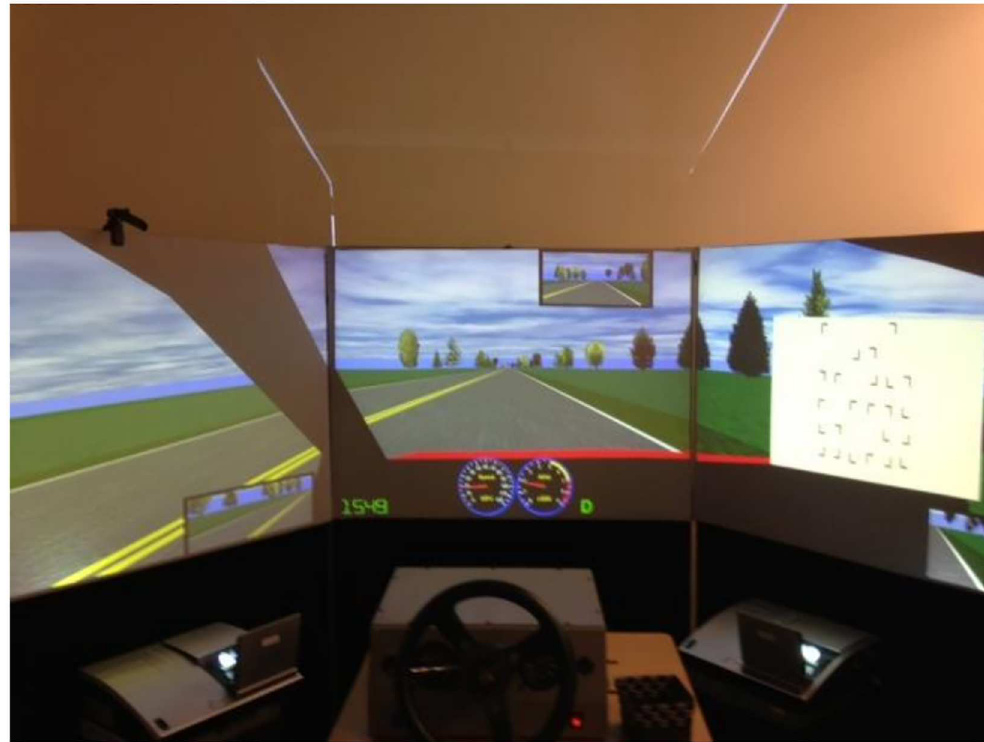
Fig 2. A sample display of highway scenarios in a rural environment with the concurrent search